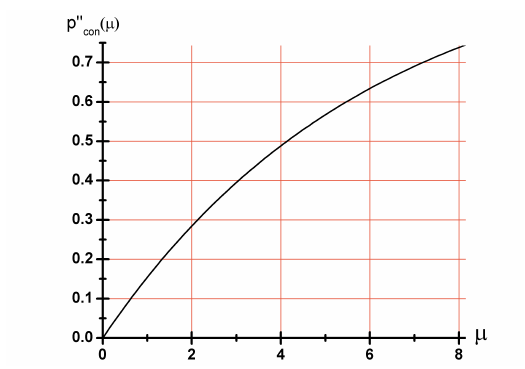
Figure 3. The probability that a malicious Bob gets a conclusive bit changing with µ .